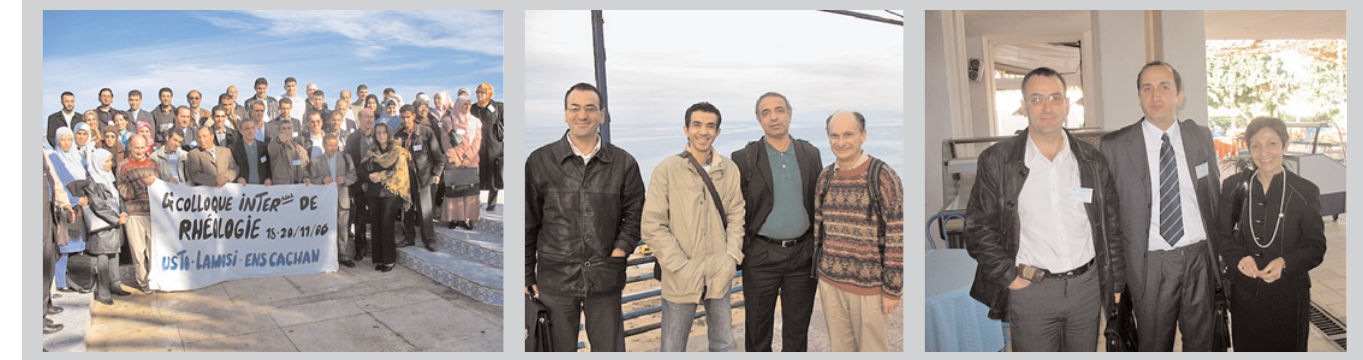
Figure 1 (left): CIR04 participants. Figure 2 (middle): From the left to the right, M. Chaouche, L. Benyahia, A. Benallal, and J. Rajchen- bach. Figure 3: From the left to the right, M. Chaouche, M. Lounis, and N.